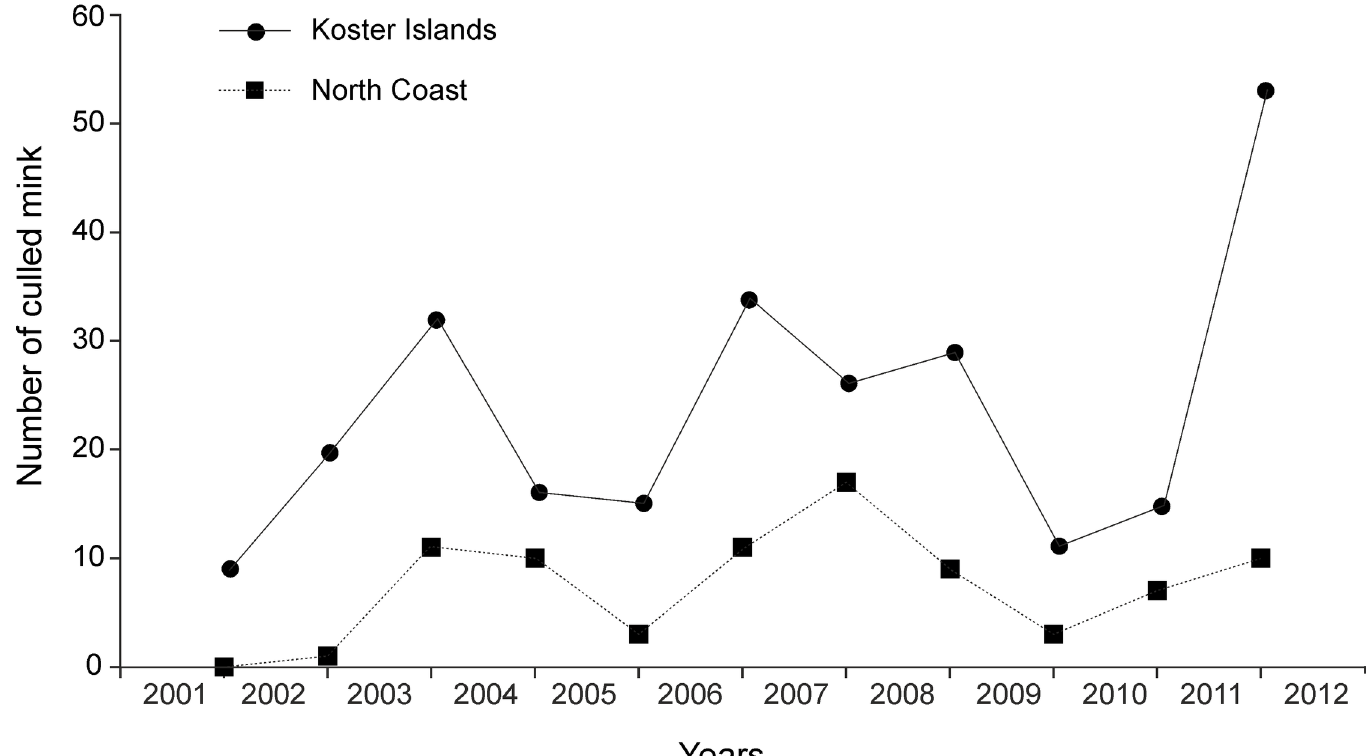
Fig 2. Number of American mink removed from Koster Islands and the North Coast in consecutive culling seasons.